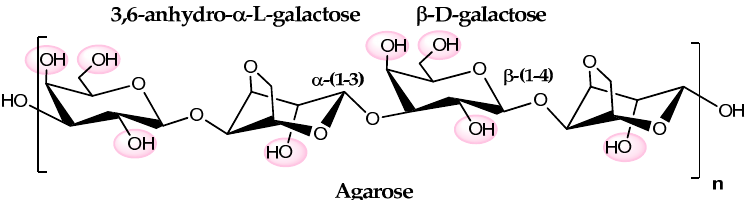
Figure 3. Schematic representation of the backbone structure of agarose: β - D -galactose and 3,6-anhydro- α - L -galactose, linked by glycosidic bonds β -(1–4) and α -(1–3). The light pink circles randomly highlight the hydroxyl groups that can be chemically modified.